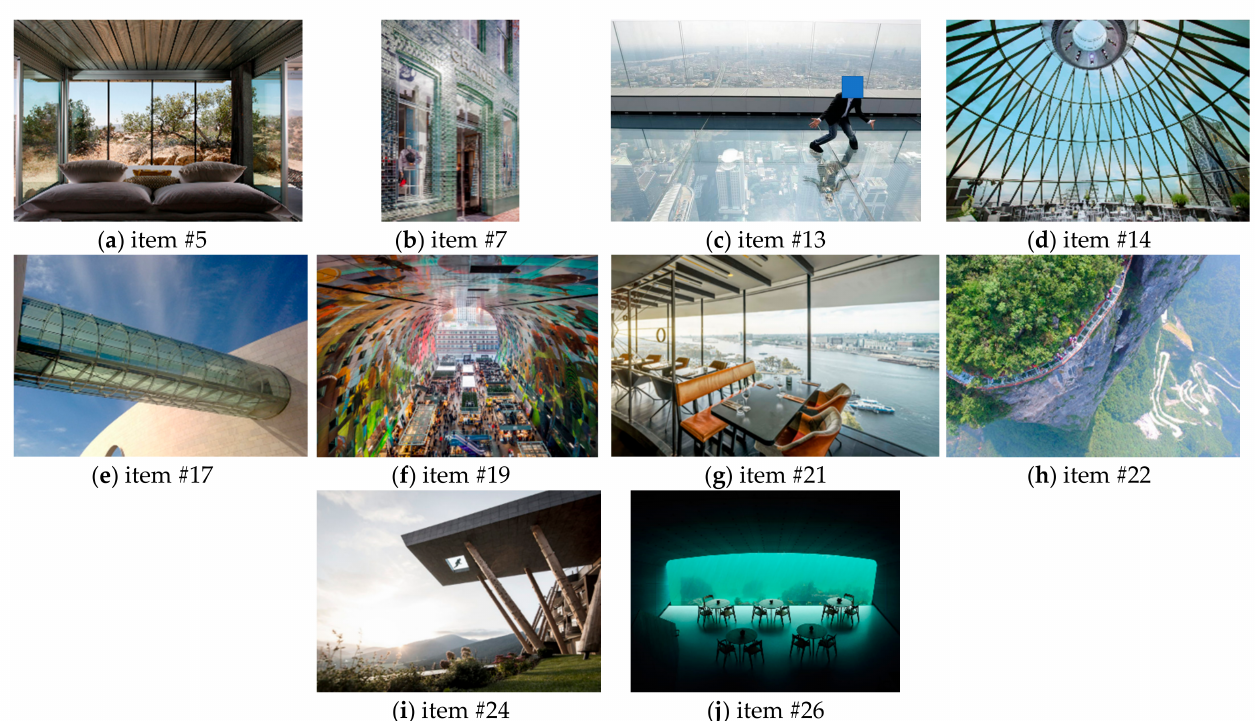
Figure 14. Static items with mostly balanced POS & NEG reactions: ( a ) private room (Off-grid itHouse, Pioneertown, USA; adapted from [38], © Airbnb); ( b ) glass bricked wall (Chanel Amsterdam Store, NL; adapted from [52], © MVRDV); ( c ) skywalk (Mahanakhon, Bangkok, THA; adapted from [53], © Tripadvisor); ( d ) roof (30 St Mary Axe Tower, London, UK; adapted from [54], © Nigel Young - Foster + Partners, Richard Bryant); ( e ) footbridge (Lisbon, PT; adapted from [55], © Schlaich Bergermann Partner); ( f ) Markthal, Rotterdam, NL (adapted from [56], © MVRDV) ( g ) walls for the 360 revolving restaurant Moon in Amsterdam, NL (adapted from [57], © A’DAM Lookout); ( h ) walkway (Coiling Dragon Cliff skywalk, CN; adapted from [58], © VCG via Getty Images); ( i ) swimming pool (Hubertus Hotel (Valdaora, IT; adapted from [59], © Design and Contract)); ( j ) underwater restaurant in Norway (adapted from [60], © Dezeen).